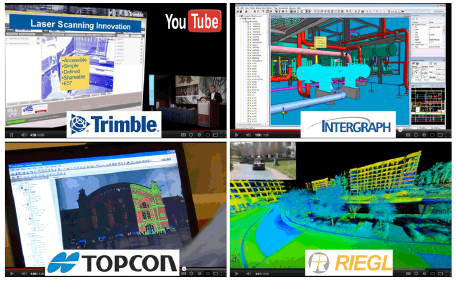
Figure 14: YouTube presence by different